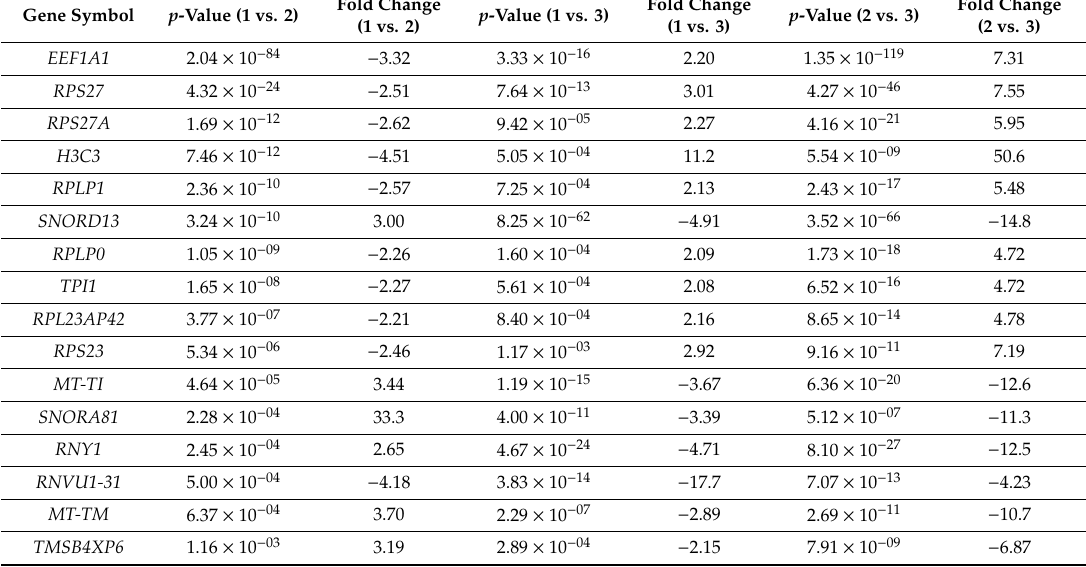
Table 2. Top Di ff erentially Expressed Genes. The gene-specific analysis was used to test for di ff erential expression of genes or transcript between sample regions in Partek ® Flow ® . Statistical cuto ff are made by these following parameters: p -value <= 0.05; FDR step up <= 0.05; Fold Change < − 2 or > 2. Gene Symbol p -Value (1 vs.